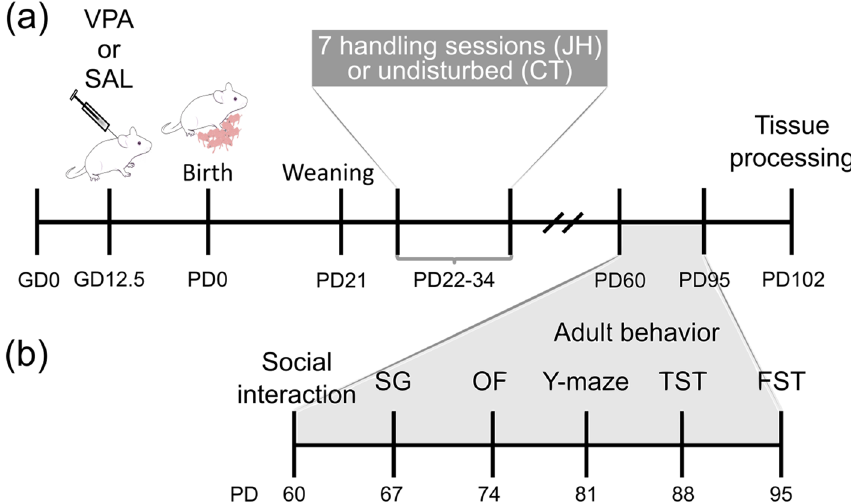
Figure 1. Experimental design. ( a ) Animals were prenatally exposed to valproic acid (VPA) or saline (SAL), weaned at postnatal day (PD) 21 and then subjected to juvenile handling (JH) or left undisturbed (CT). ( b ) In adulthood, animals were evaluated in the social interaction test, self-grooming test (SG), open field test (OF), Y-maze test, tail suspension test (TST) and forced swim test